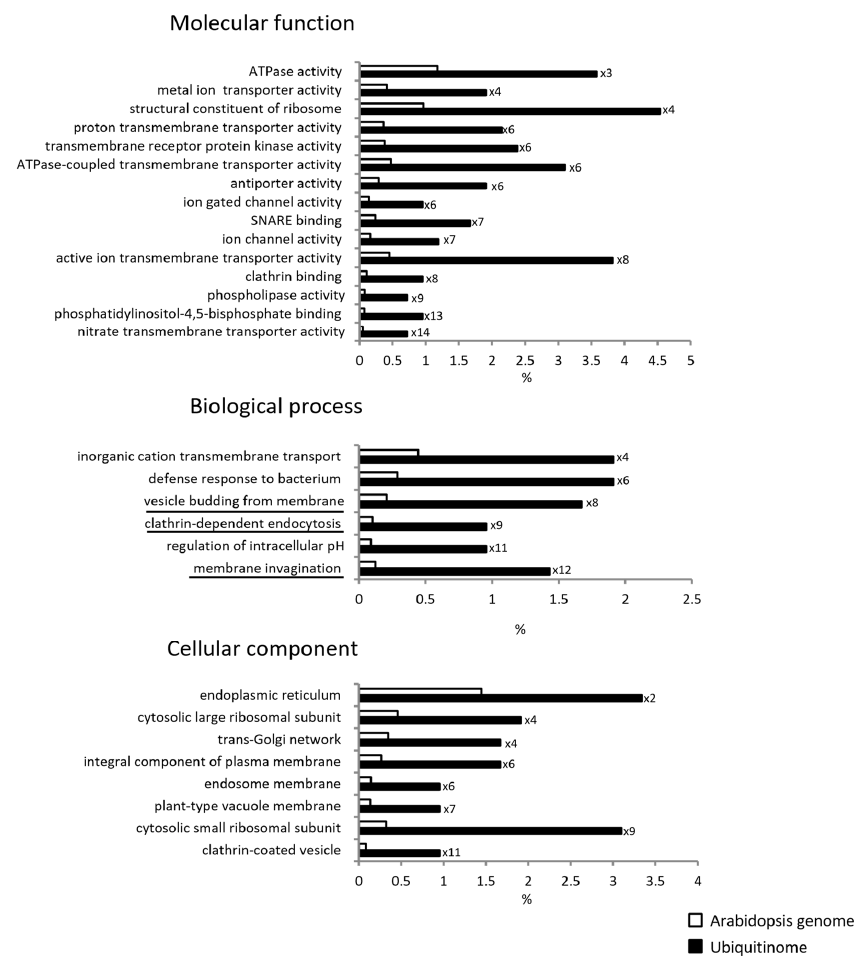
Figure 2. Functional enrichment analysis of ubiquitinated root microsomal proteins. The percent- age is calculated with regard to the number of identified ubiquitinated proteins (black) and the total number of Arabidopsis proteins (white). Numbers indicate the fold enrichment by comparison with the Arabidopsis genome. Underlined biological processes concern proteins involved in intracellular trafficking and include 15 genes (Table S3).